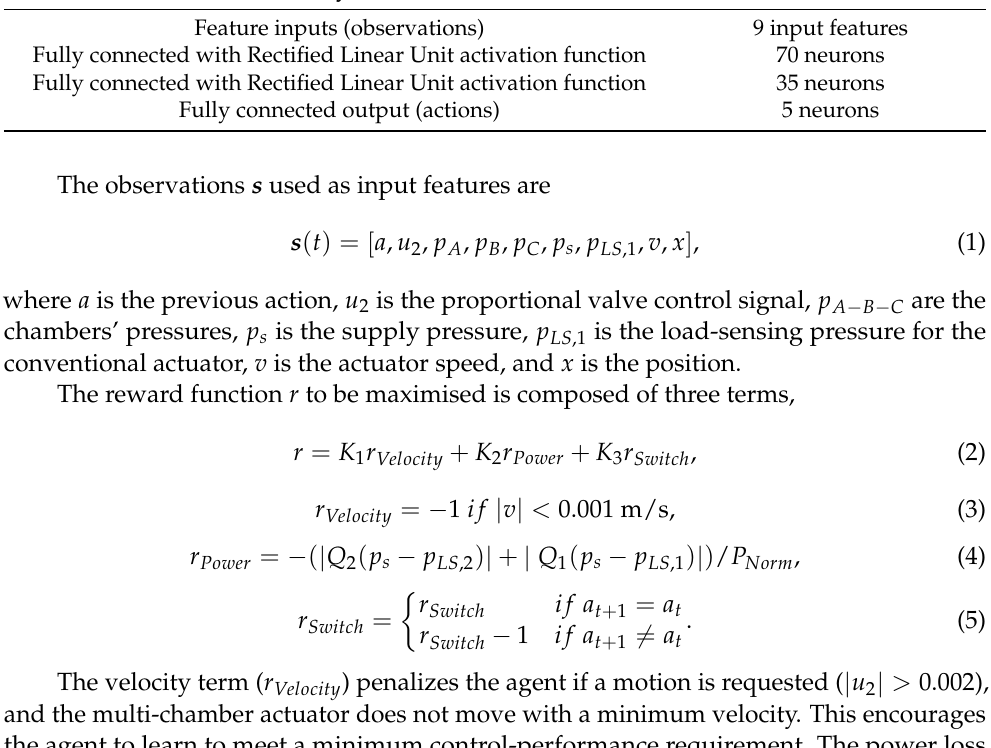
Table 2. Structure of the agent network. Layer Size Feature inputs (observations) 9 input features Fully connected with Rectified Linear Unit activation function 70 neurons Fully connected with Rectified Linear Unit activation function 35 neurons Fully connected output (actions) 5